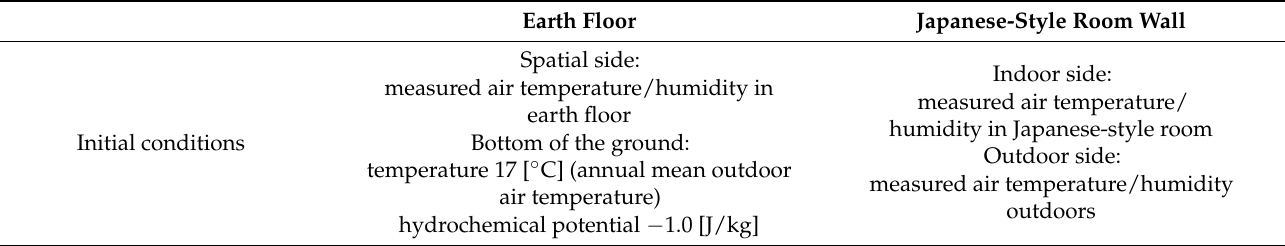
Table A1. Initial and boundary conditions and calculation domains for numerical